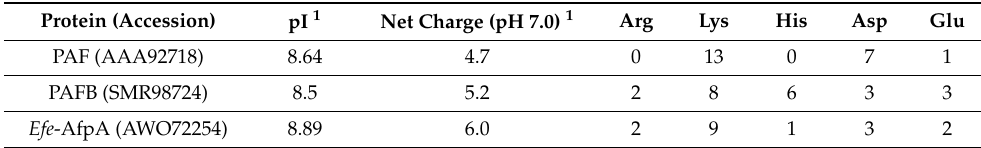
Table 4. Characteristics of the mature amino acid sequences of PAF, PAFB, and Efe -AfpA The numbers of charged amino acids in each protein are given.